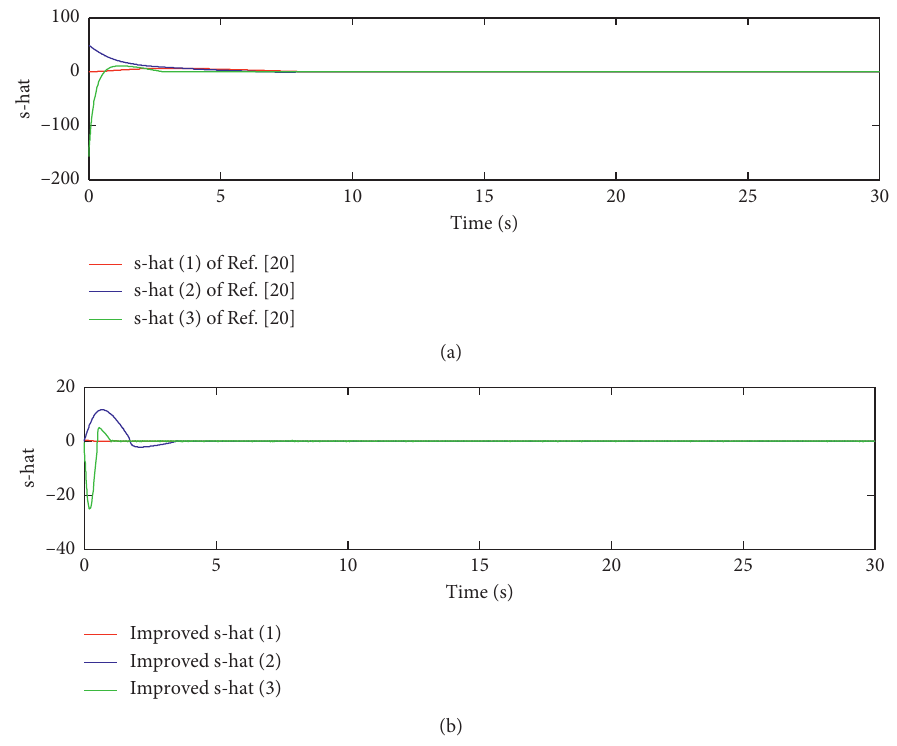
Figure 7: The sliding surface of [20] and the improved sliding surface of this paper.